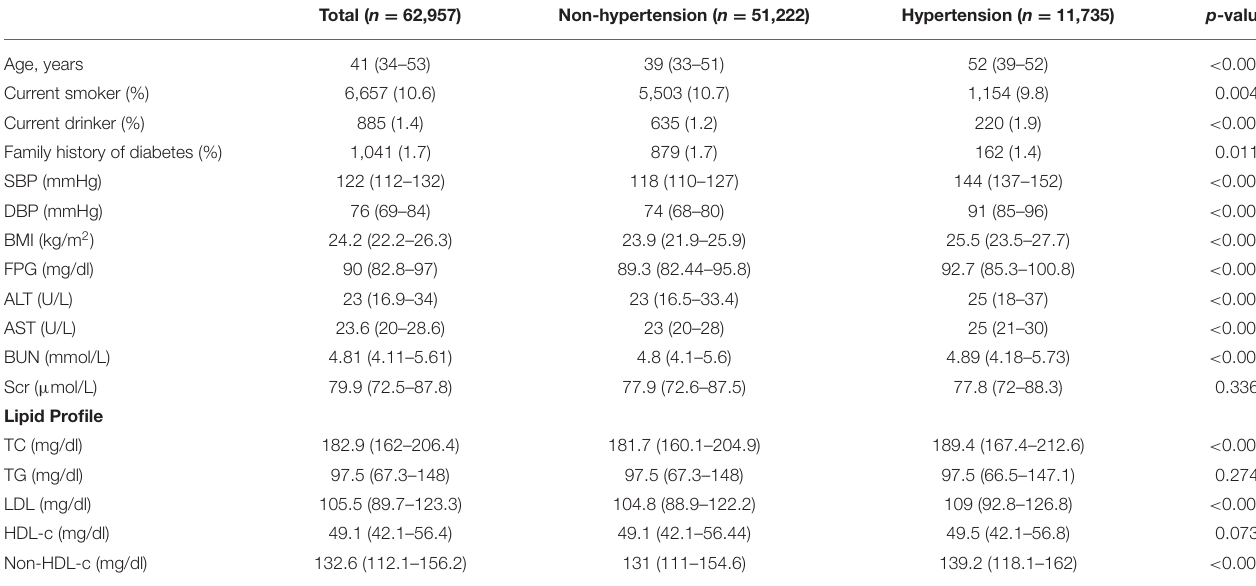
TABLE 1 | Baseline information of the overall males *